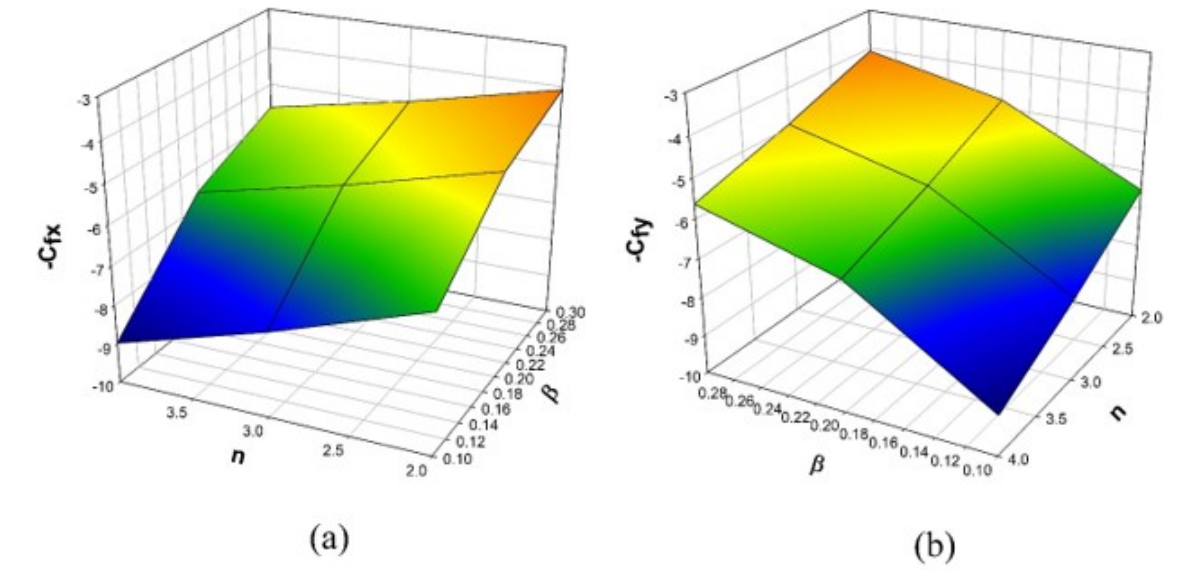
Figure 8. ( a ) Consequence of n and β over C fx , ( b ) Consequence of n and β over C fy .